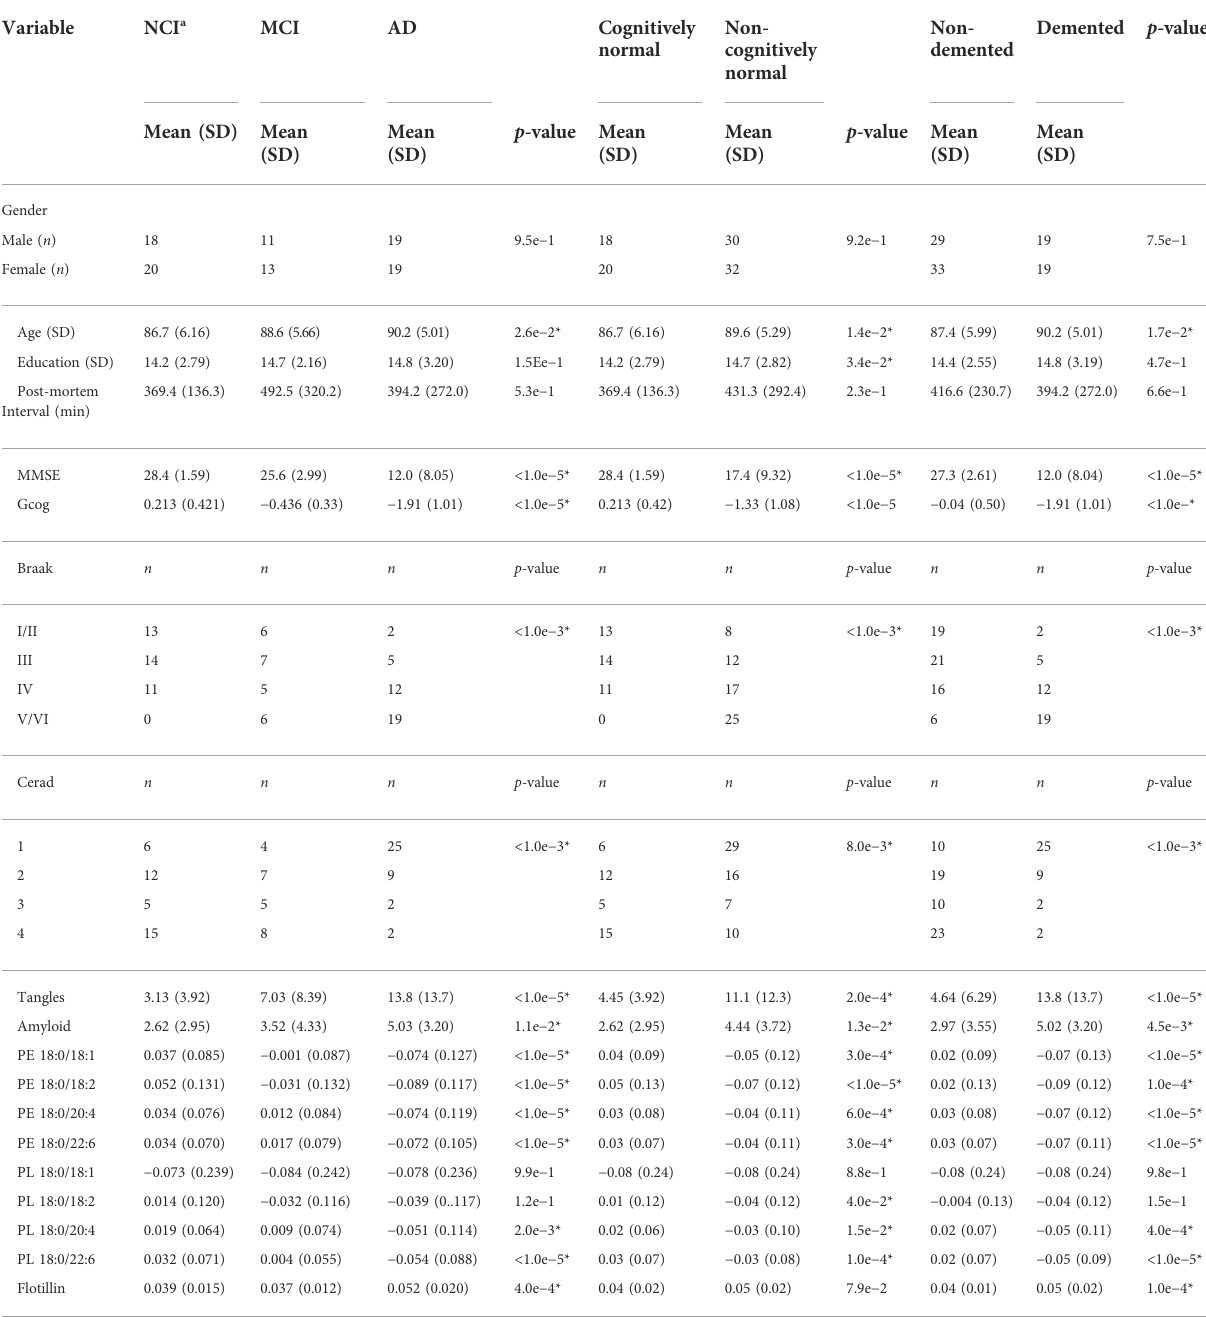
TABLE 1 Demographic, clinical and biochemical summary of the study cohort.